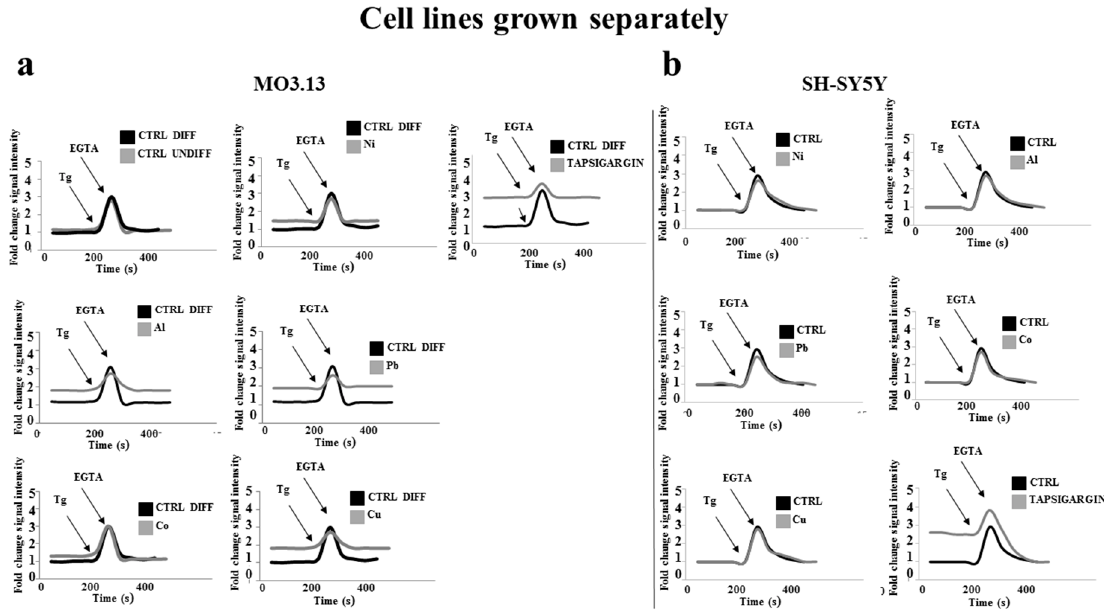
Figure 10. Measurement of cytosolic calcium in oligodendrocytes and neurons grown separately. Di ff erentiated human oligodendrocytes and human neurons were grown separately and treated with heavy metals for 24 h. At the end of the treatment, the cells were exposed to Rhod 2 and subjected to flow cytometric analysis. The cells were then exposed to 1 µ M thapsigargin for 200 s and a new flow cytometric reading was performed. After 100 s, ethylene glycol-bis( β -aminoethyl ether)-N,N,N (cid:48) ,N (cid:48) -tetraacetic acid (EGTA) 500 µ M was added to chelate calcium. A new flow cytometric reading was performed. Panel ( a ) shows the curves built on the achieved results from the flow cytometric readings performed on oligodendrocytes under the experimental conditions described above. Each graph refers to a di ff erent metal as shown in the figure. Panel ( b ) shows the curves built on the values obtained from the flow cytometric readings performed on neurons under the experimental conditions described above. Each graph refers to a di ff erent metal as evidenced in the figure. Values of three independent experiments are indicated. A representative image is shown. Analysis of Variance (ANOVA) followed by the Tukey-Kramer comparisons